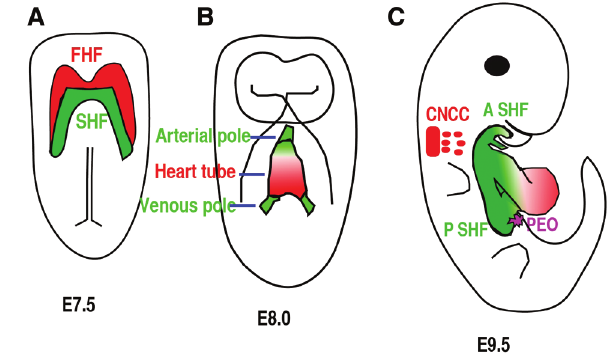
Figure 2: Four different cell sources contribute to heart formation. (A) Ventral view of an E7.5 embryo. Red color highlights the cardiac progenitor cells of the first heart field (FHF), and green color highlights another subset of cardiac progenitor cells that form the secondary heart field (SHF) and is located posteriorly and medially to the FHF. (B) Ventral view of the embryo at E8.5. Cells from the FHF migrate and then merge in the midline to form the heart tube, which then elongates on both arterial and venous poles via the addition of progenitor cells from the SHF. (C) Right lateral view of an E9.5 mouse embryo. The cardiac neural crest cells (CNCC) at rhombomere 6–8 gives rise to cells (green) that migrate to and colonize the distal cardiac outflow tract (OFT) to contribute to OFT alignment and septation. Cells from pro-epicardial organ (PEO) will migrate, attach, and then cover the whole heart to form epicardium. A SHF, anterior second heart field; P SHF, posterior second heart